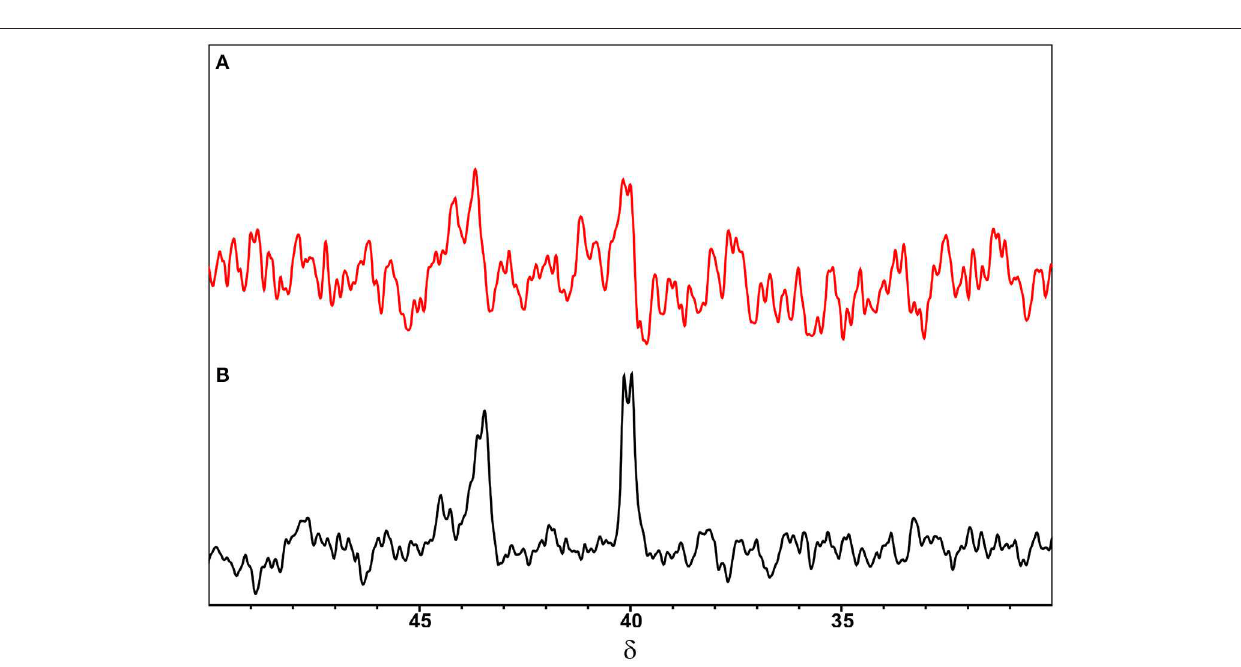
FIGURE 4 | 31 P-NMR spectra obtained for CBLAU (5mM): (A) with (red) and (B) without (black) CT-DNA (50 µ M) at 161.96 MHz (for 31 P nucleus) in DMSO:buffer (5:95 v/v) at 298K.